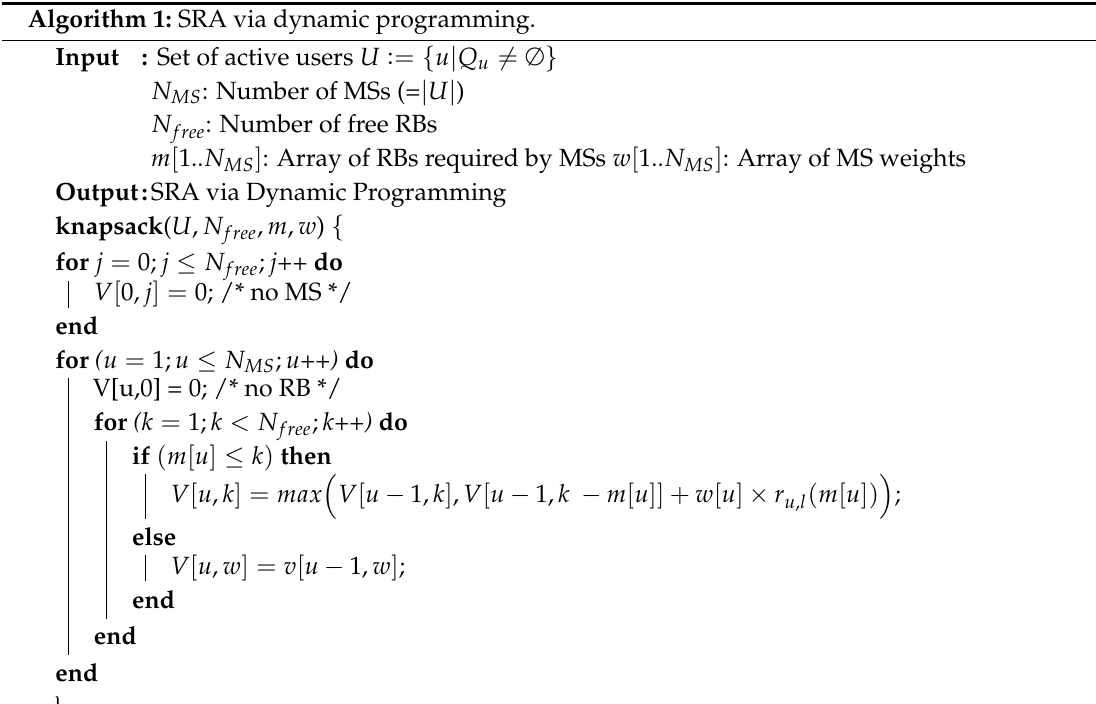
Algorithm 1: SRA via dynamic